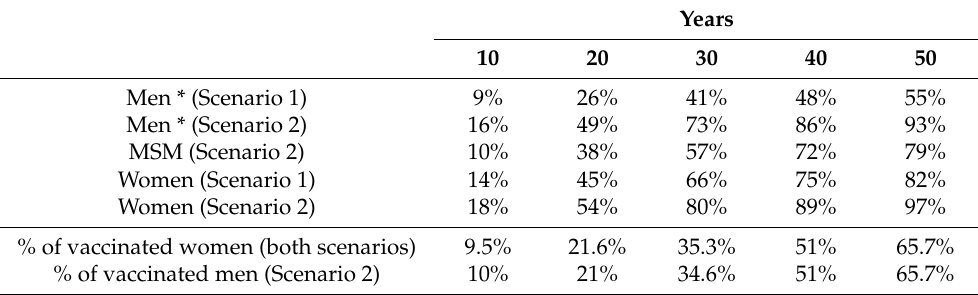
Table 2. Averted HPV 6/11